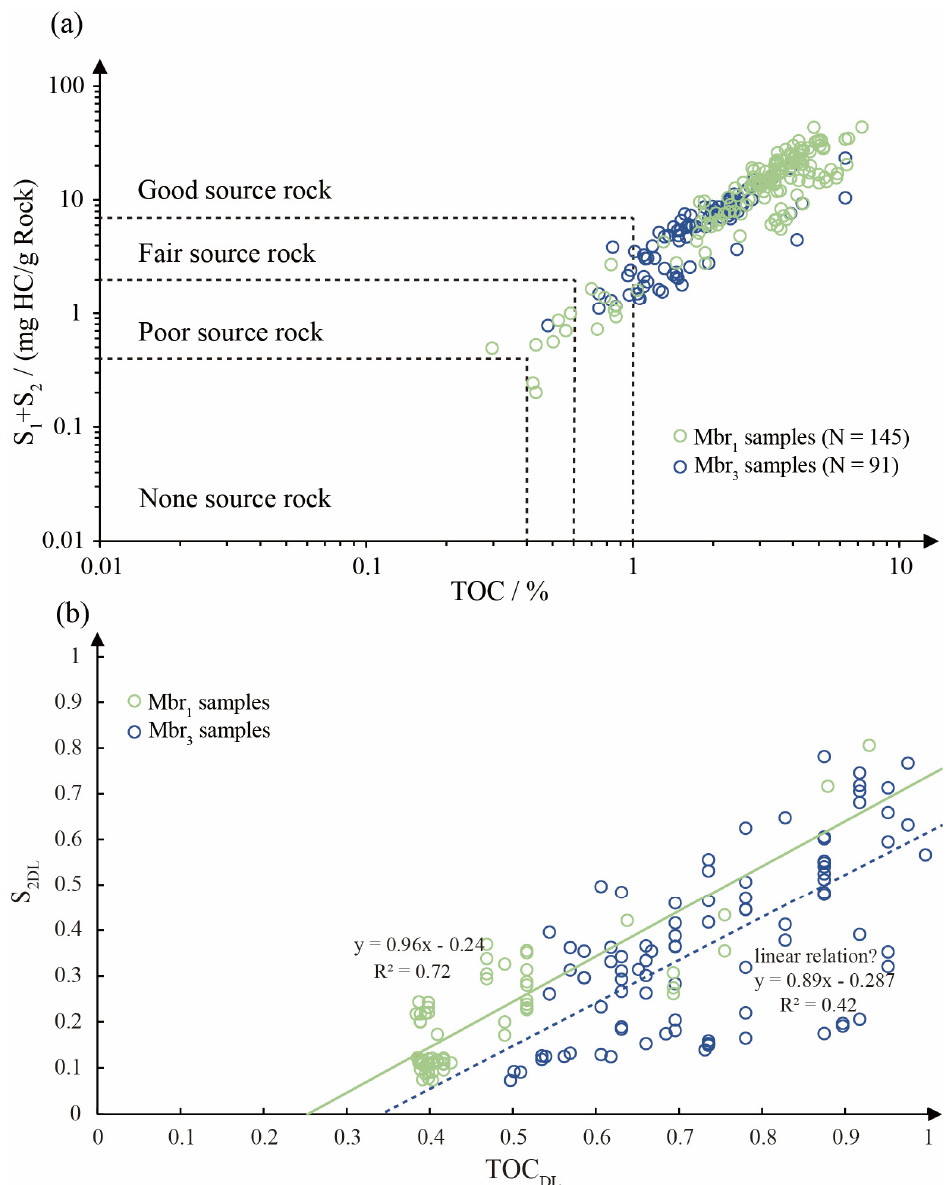
Figure 4. Cross−plots for judging source rocks quality. ( a ) S 1 +S 2 versus TOC plot [32]; ( b ) dimen- sionless TOC versus S 2 plot for kerogen type and generation potential judgement [19].